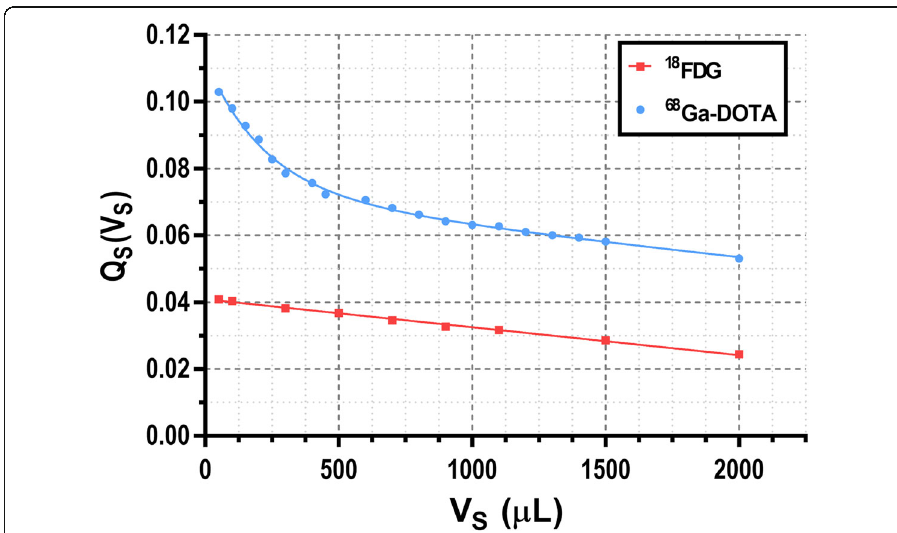
Fig. 3 Variation of Q S values measured with the well counter for pure 18 F (red squares) and 68 Ga (blue circles) with different sample volumes ( V S ). Results were fitted to a straight line and a sum of two exponentials respectively in order to obtain the Q S values for different